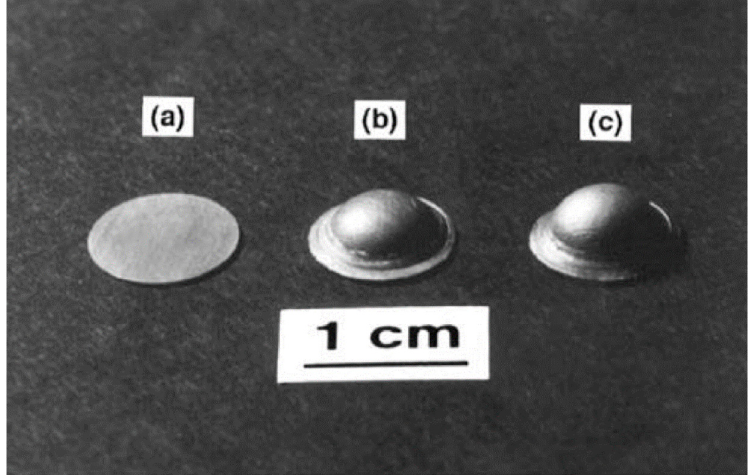
Figure 9. Examples of domes formed in an Al–Mg–Sc alloy after imposing a pressure of 1.0 MPa for ( a ) 0, ( b ) 30 and ( c ) 60 s, respectively [38].